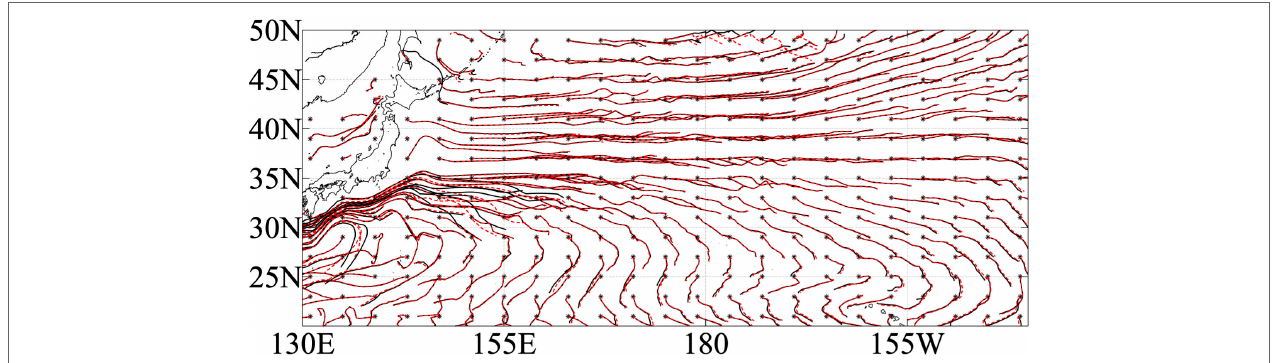
FIGURE 9 | One-year Lagrangian trajectories of water parcels released at the base of the March mixed layer in 2006 for NOCHL (black line) and CLIMCHL (red line). Stars indicate the starting point of the released parcels.